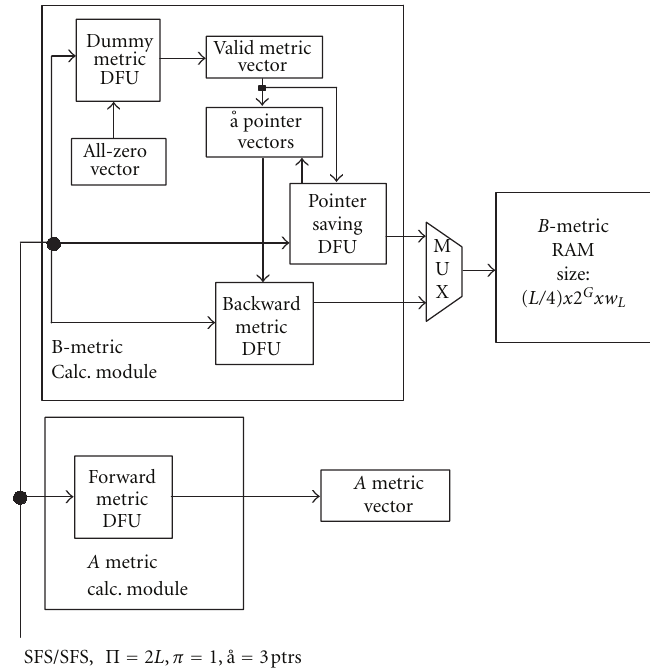
Figure 12: State metric calculation modules for single-flow structures using the pointer